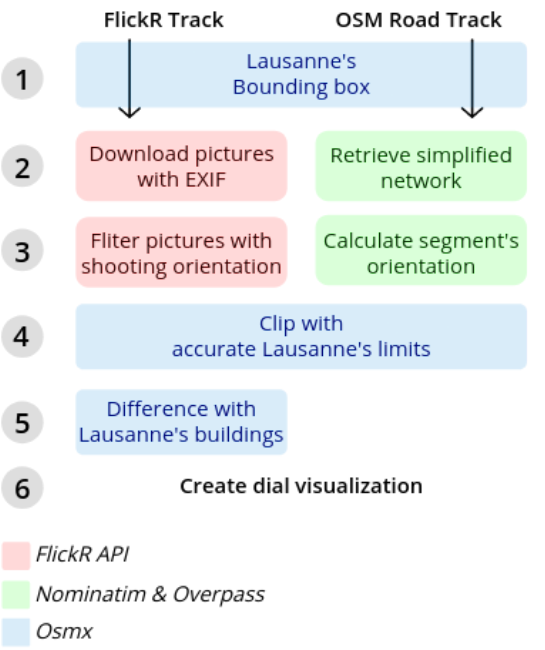
Figure 2: Schematization of the workflow adopted to extract, filter and visualize the data from OSM and FlickR.